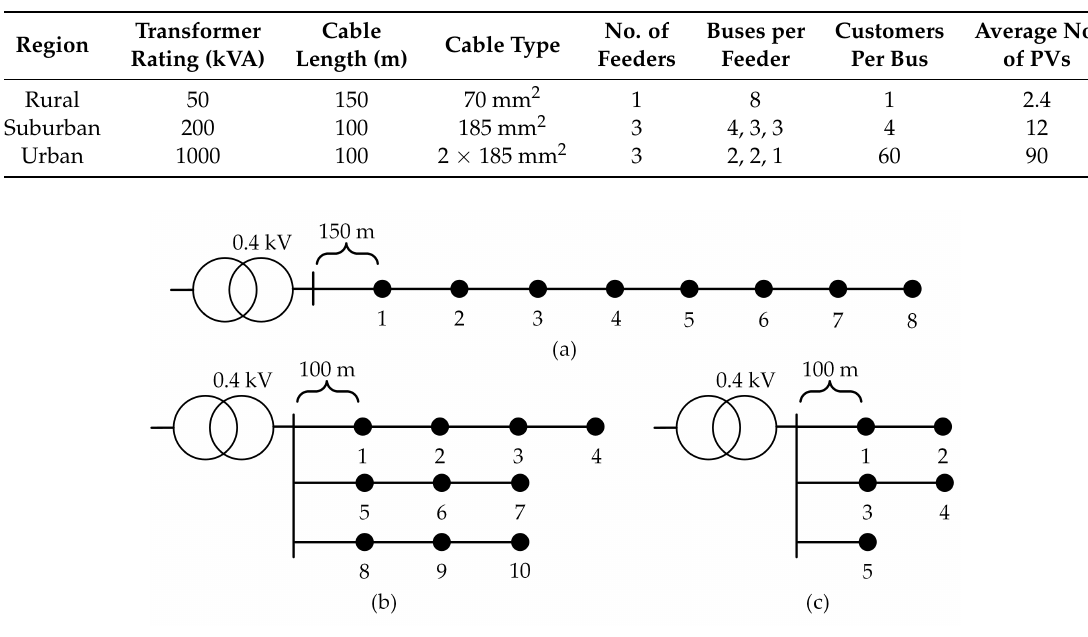
Figure 2. Networks modeled for rural ( a ), suburban ( b ) and urban ( c )